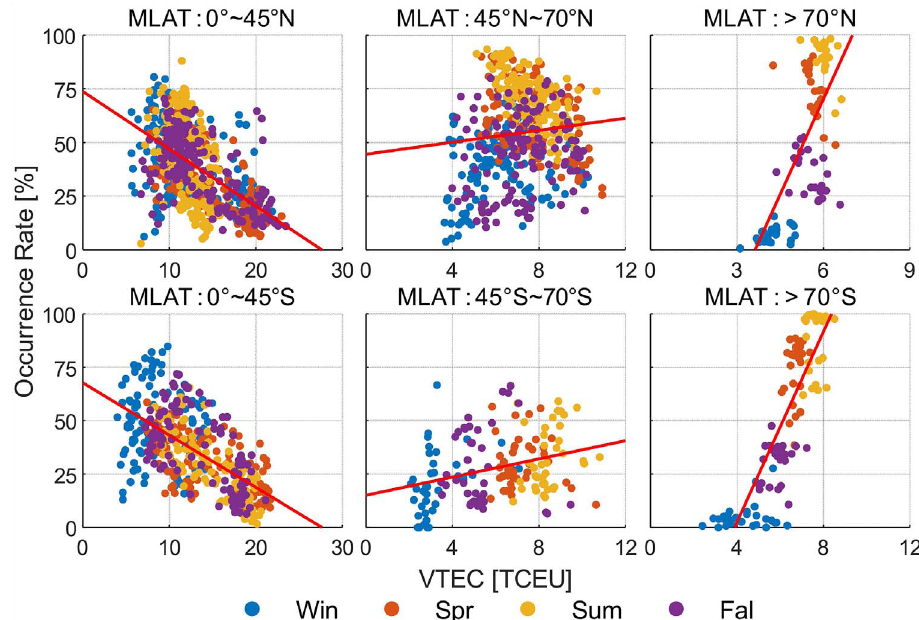
Figure 5. The variation of the DDM occurrence rate of each station in each season in different magnetic latitude areas with its background VTEC. In the fi gure, MLAT represents the magnetic latitude, and the solid red line results from the fi rst-order linear fi tting of each